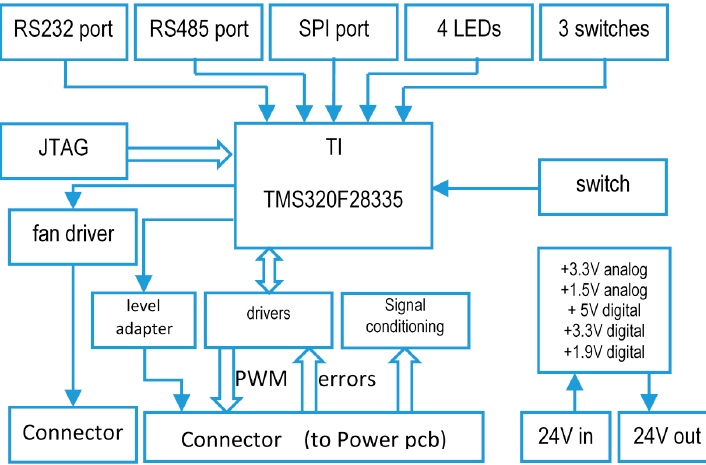
Figure 4. Simplified bloc-schematic of the control board.